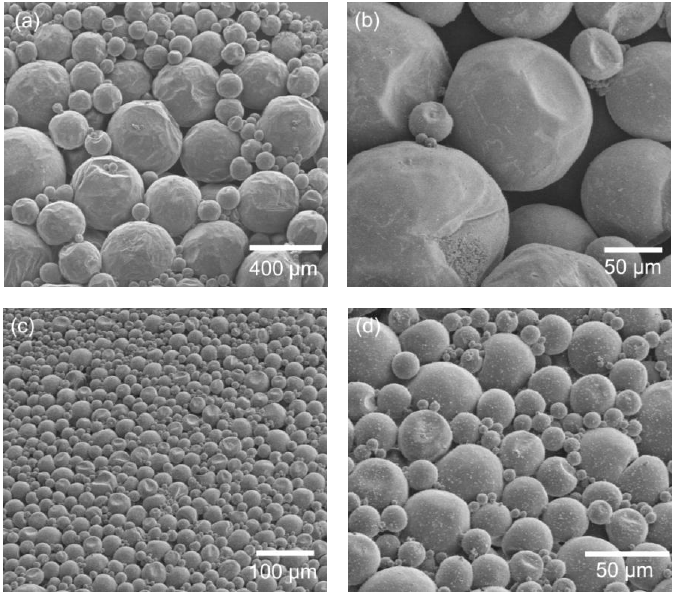
Figure 3. SEM images of n -eicosane-encapsulated microcapsules prepared at different emulsification speeds: ( a , b ) 1200 rpm and ( c , d ) 2000 rpm. The polymerization time and surfactant volume were 2 h and 28 mL, respectively.